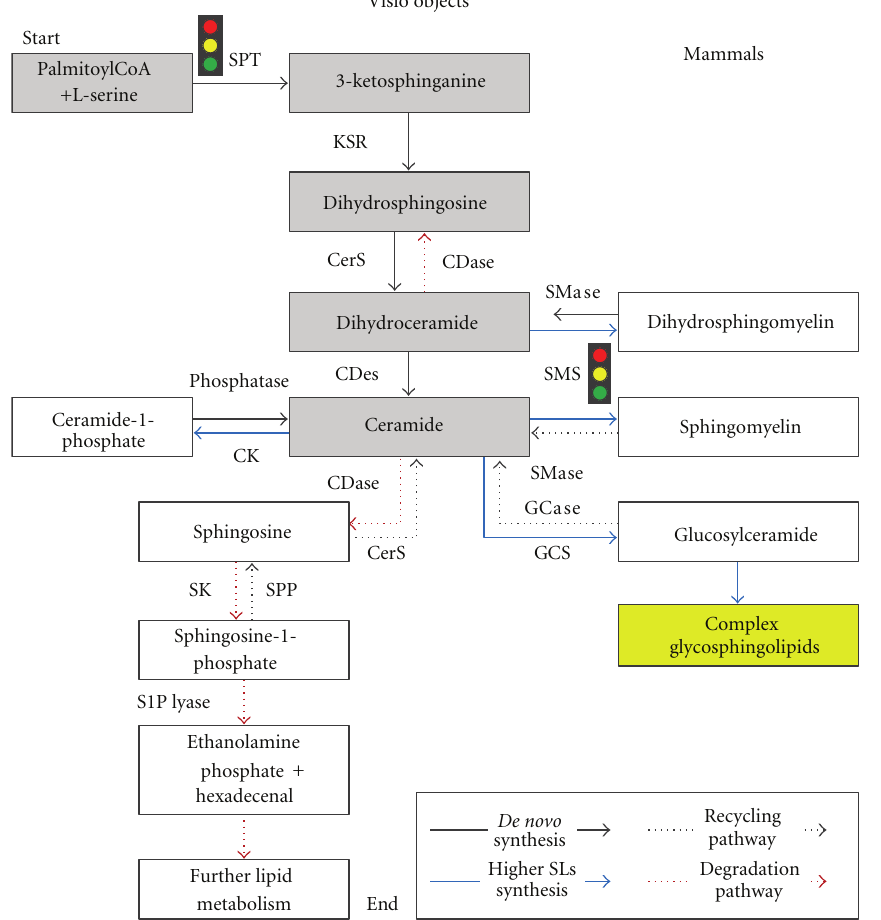
Figure 2: A simplified diagram of sphingolipid metabolism in mammals. The key regulatory synthetic steps are indicated by the “tra ffi c light” symbols. SPT: Serine Palmitoyltransferase; 3-KSR: 3-Ketosphingosine Reductase; CerS: Ceramide Synthase; CDase: Ceramidase; CDes: Ceramide Desaturase; SMS: Sphingomyelin Synthase; SMase: Sphingomyelinase; CK: Ceramide Kinase; GCS: Glucosylceramide